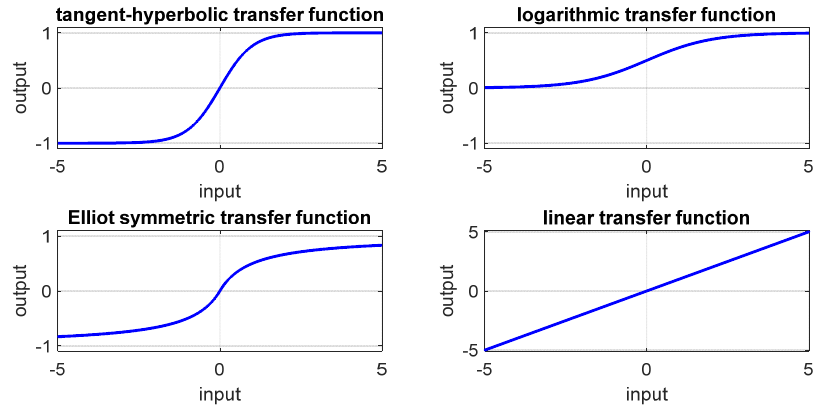
Figure 6. Activations transfer functions. Source: Authors’ elaboration.